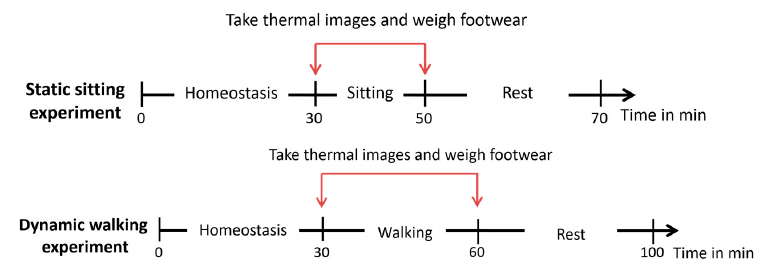
Figure 2. Experimental procedures.